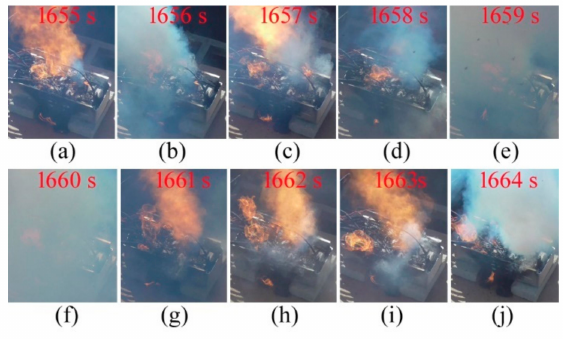
Figure 5. Alternate ejection of gas and